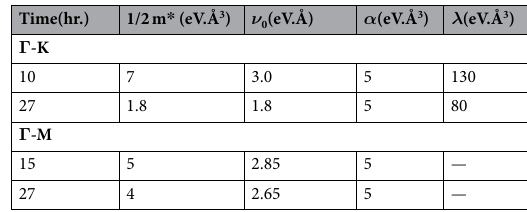
— Table 1. Parameters of calculated SSBs obtained after fitting with the E-k dispersion relation Eq. (1) estimated from the ARPES data along the Γ -K and the Γ -M